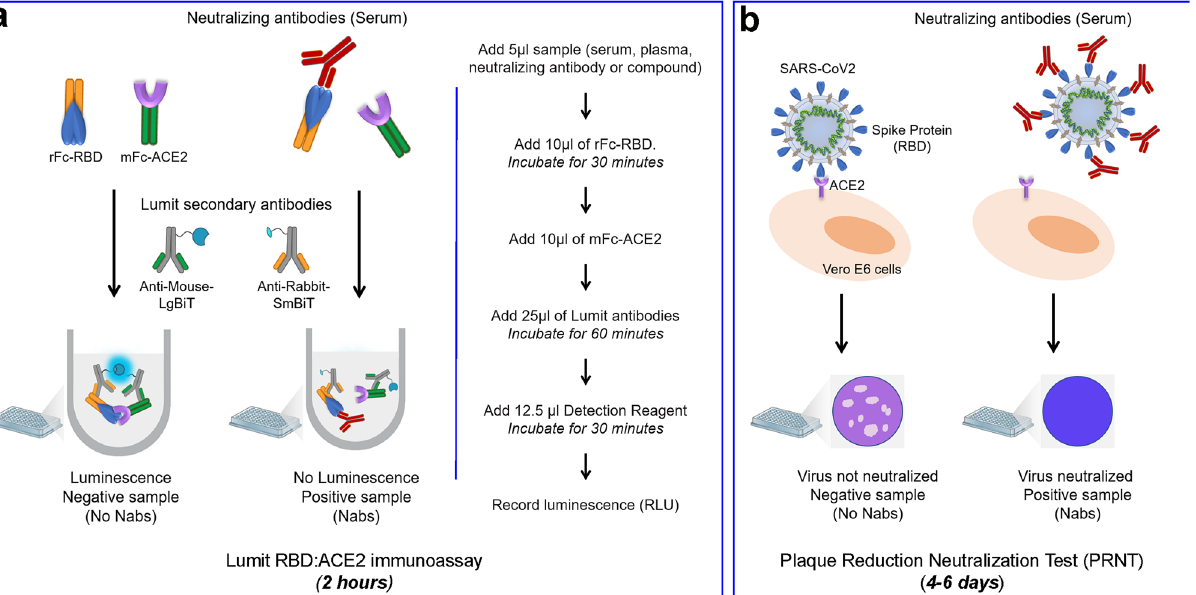
Figure 1. Schematic representation of the Lumit SARS-CoV-2 Spike RBD:ACE2 Immunoassay and comparison with PRNT assay. ( a ) Lumit SARS-CoV-2 Spike RBD:ACE2 Immunoassay detects the interaction between the rabbit Fc-tagged RBD fragment of SARS-CoV-2 Spike protein and the soluble mouse Fc-tagged ACE2 receptor through binding of LgBit/SmBit-conjugated Lumit secondary antibodies. Lumit secondary antibody recognition of RBD:ACE2 interaction leads to NanoLuc fragments complementation and bioluminescent signal. Lumit SARS-Cov-2 Spike RBD:ACE2 Immunoassay protocol. Sample (i.e.: antibody, inhibitor, serum, plasma, etc.) is co-incubated with Spike RBD-rabbit Fc for 30 min at room temperature. hACE2-mouse Fc and Lumit secondary antibodies are added to the samples and the assay reactions are incubated at RT for 60